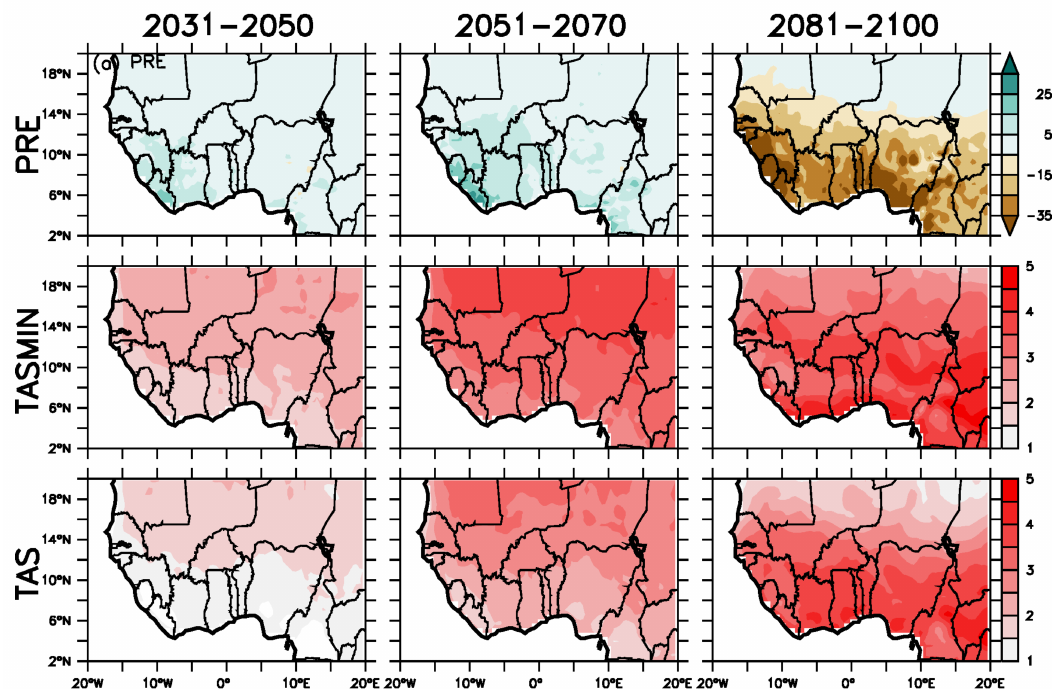
Figure 11. Projected changes in the total monthly rainfall (PRE), minimum (TASMIN) and mean (TAS) monthly temperature over West Africa as simulated by RCA4 for the near future month (2031–2050), mid-century (2051–2070) and the end of the century